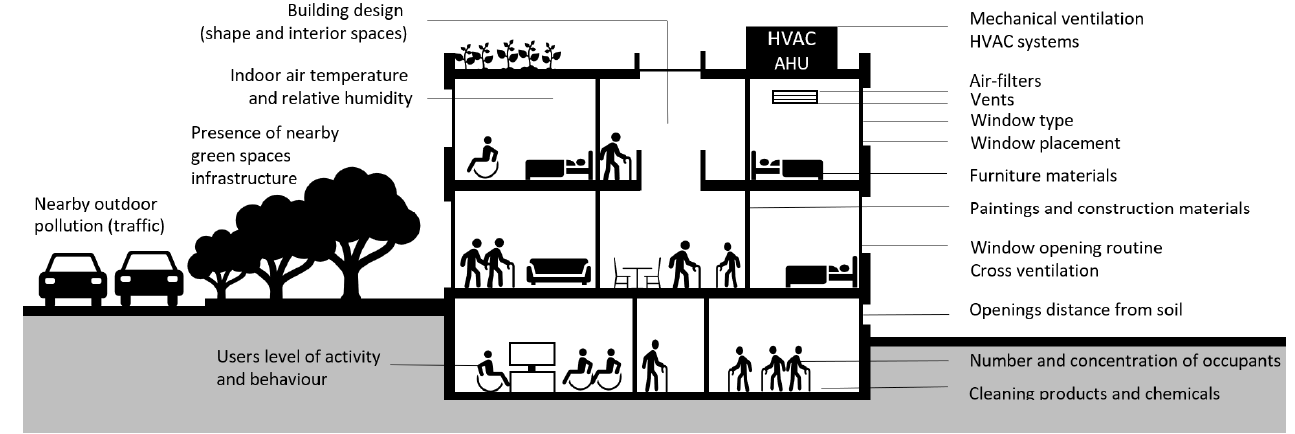
Figure 1. Factors influencing IAQ in elderly centers (authors’ own creation).